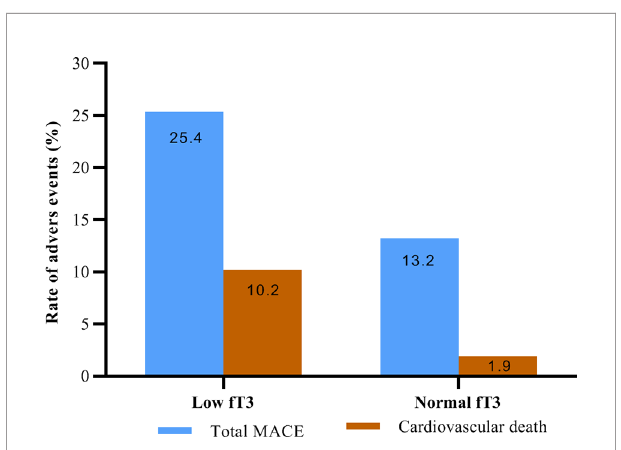
FIGURE 2 | Kaplan-Meier survival curves for cardiovascular deaths in MINOCA patients with low fT3 versus normal fT3 levels. fT3, free triiodothyronine.